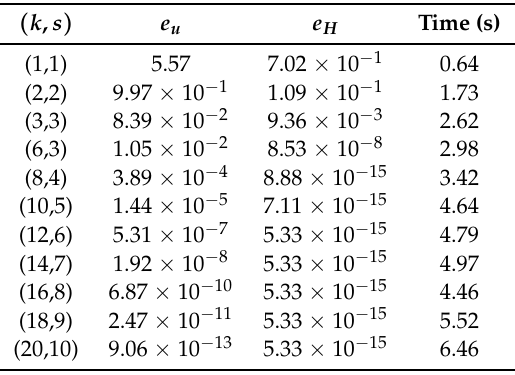
Table 3. Solution error e u and Hamiltonian error e H when solving problem (93) with stepsize h = 1 and N = 300 in (90), by using HBVM ( k , s )